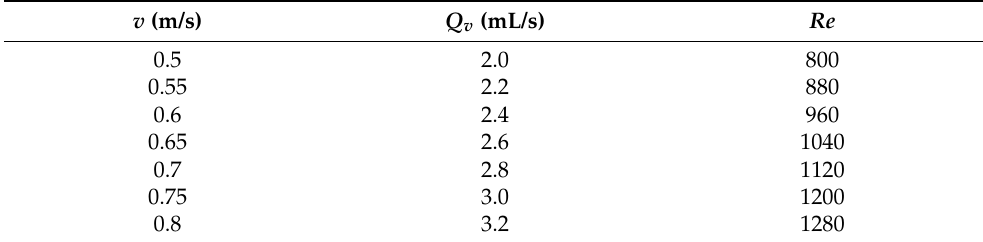
Table 4. Reynolds number at different flow